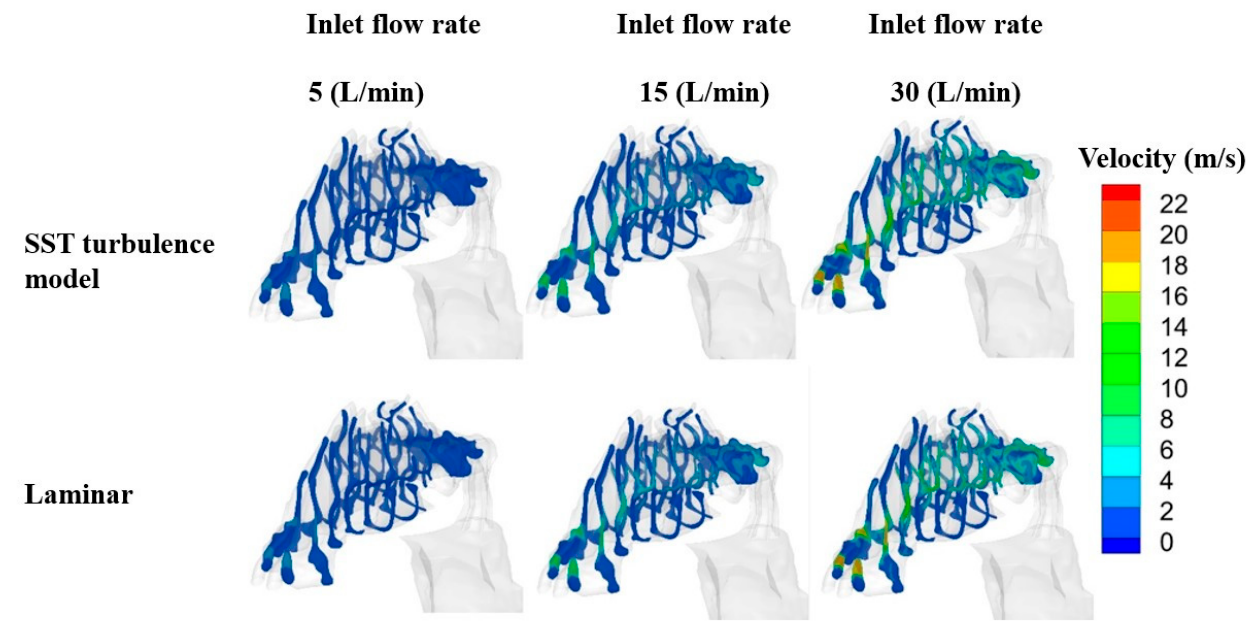
Figure 5. Velocity magnitude at different cross-sections and various inhalation rates for shear stress transport turbulence (SST) model, transient, and laminar viscous model.